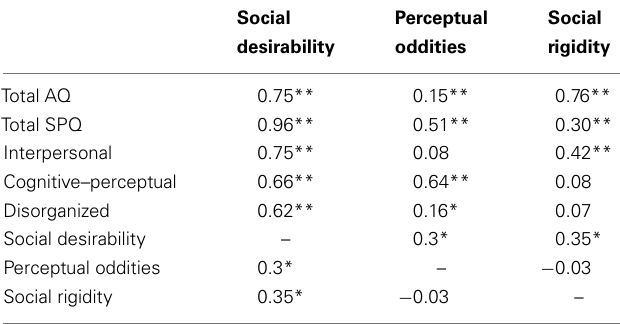
Table 5 |AQ and SPQ correlations with factor analysis factors